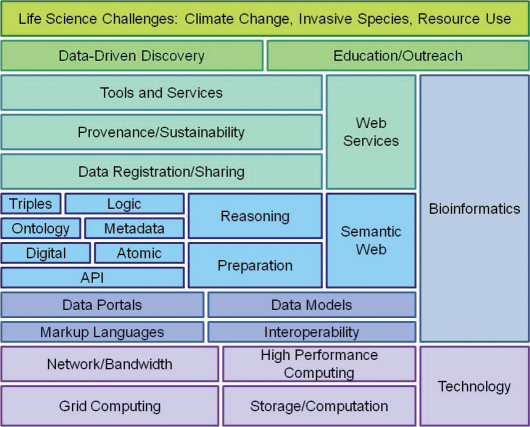
Technical infrastructure needed for Big New Biology to fully emerge (based on Sinha et al. 2010).